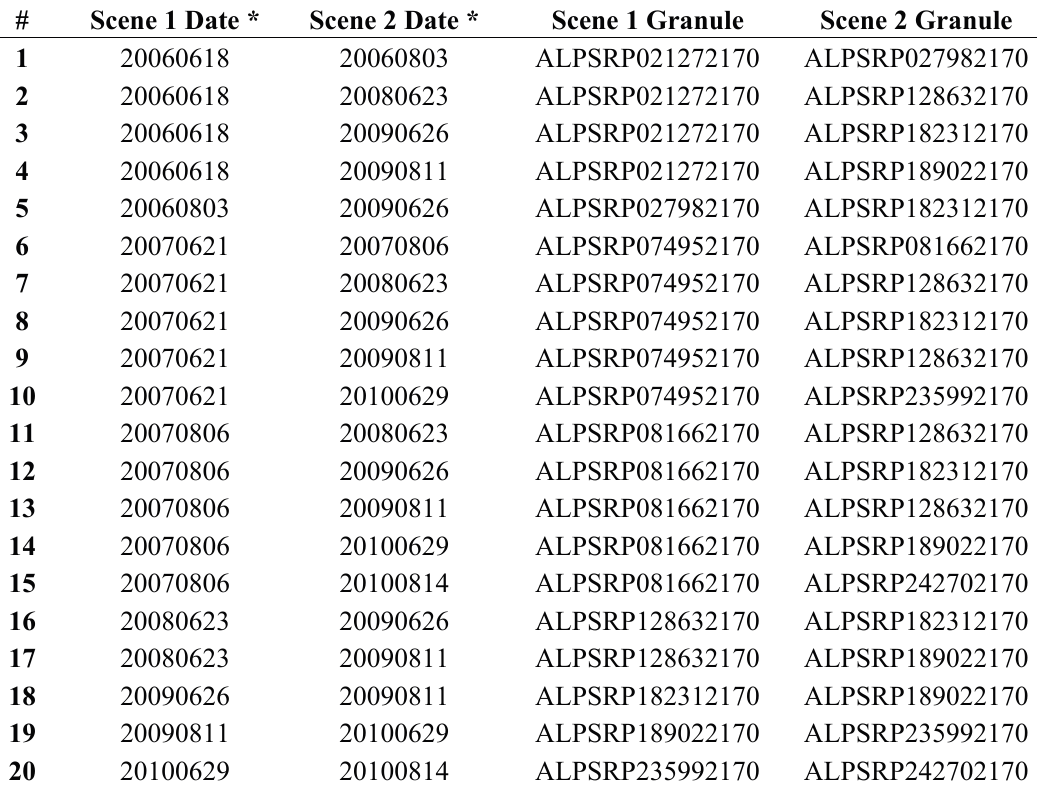
Table A1. Interferograms used in this study and the individual PALSAR scenes used to construct